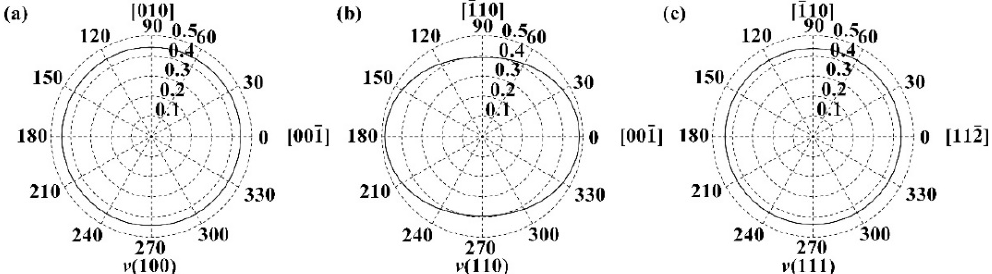
Figure 9. Direction dependence of Poisson’s ratio on low-index planes of Au 3 Cu: ( a ) (100), ( b ) (110), and ( c ) (111).